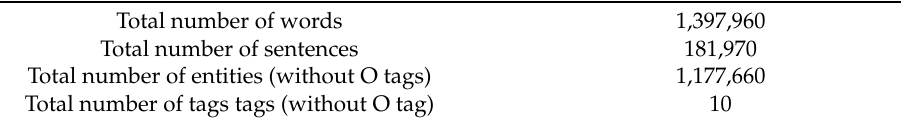
Table 5. The detailed specification of dataset.